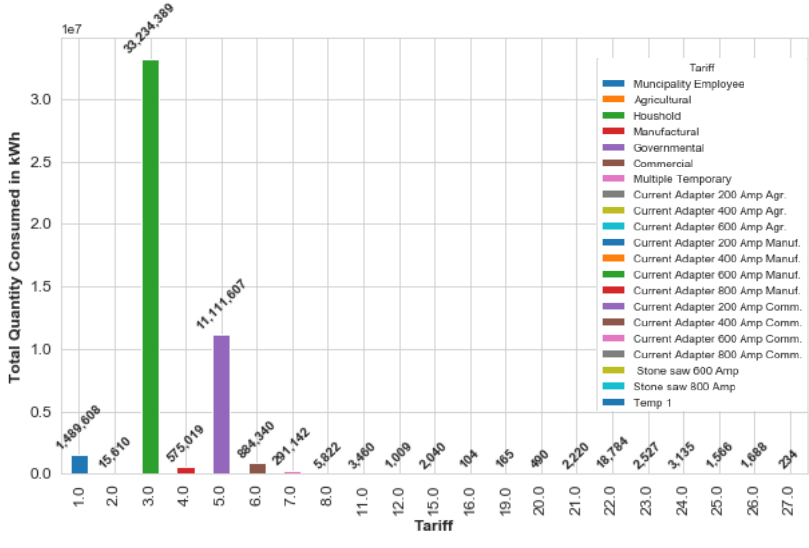
Figure 7. Electricity consumed in kWh per